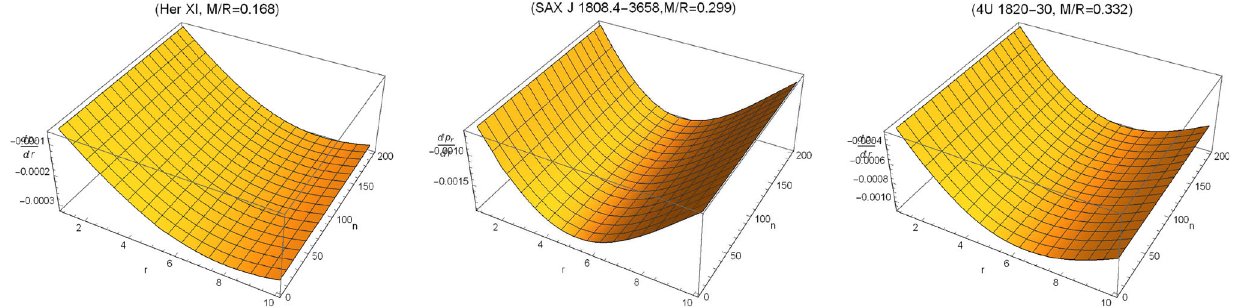
Fig. 7 Behavior of d p r with radial coordinate r (km) and model parameter d r